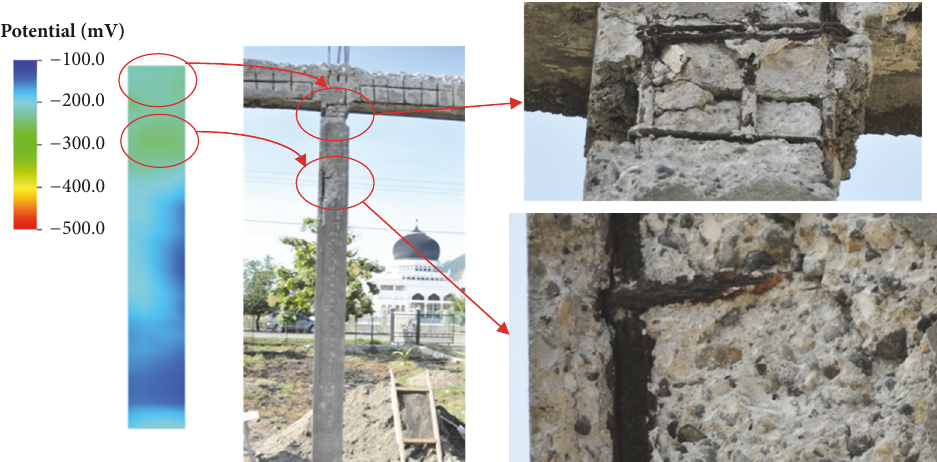
Figure 1: Comparison of half-cell potential technique result to the actual corrosion in the previous result [5].